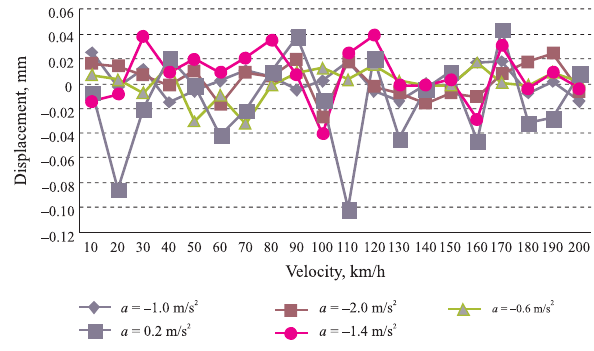
Fig. 5. Max displacement of the plate with different velocities and fixed deceleration